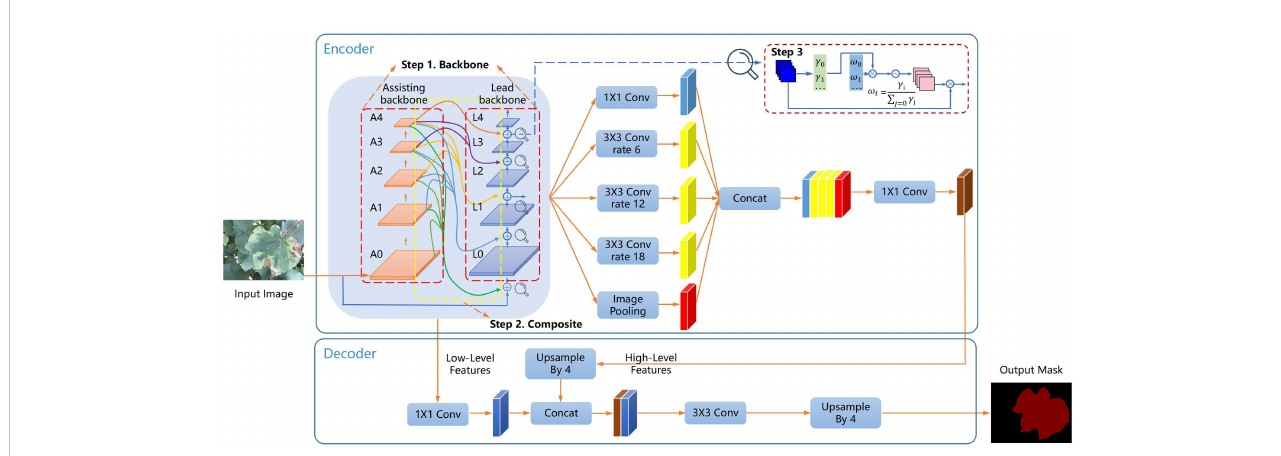
FIGURE 1 The outline of the composite backbone and segmentation architecture in our model. In step 1, the composite backbone (Xception and CoAtNet) is selected, and the features of the input image are extracted by CoAtNet. In step 2, multi-scale features are interacted in the composite backbone. In step 3, features from the composite backbone are fused using weight contribution